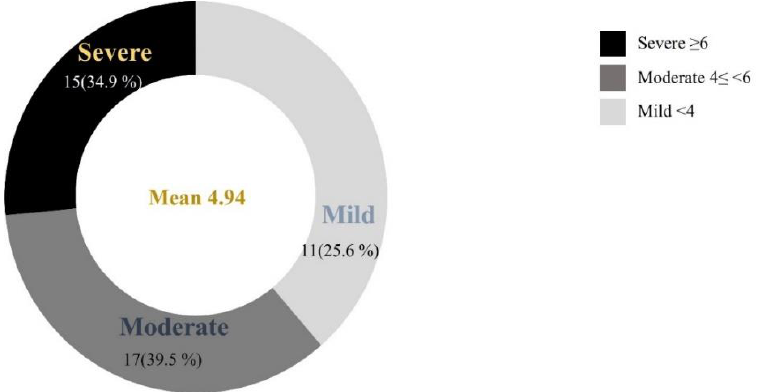
Figure 3. Distribution of patients according to the severity of phenotype based on our new scoring system (DeNuLF score).